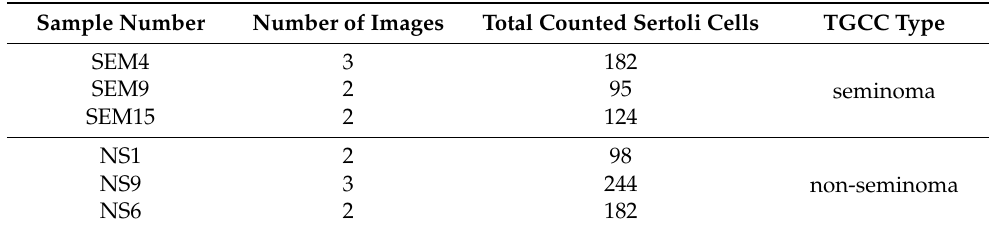
Table 3. Details of the tissue used for the quantification of cytokeratin expression in Sertoli cells of GCNIS containing tubules from seminoma (SEM) and non-seminoma (NS)